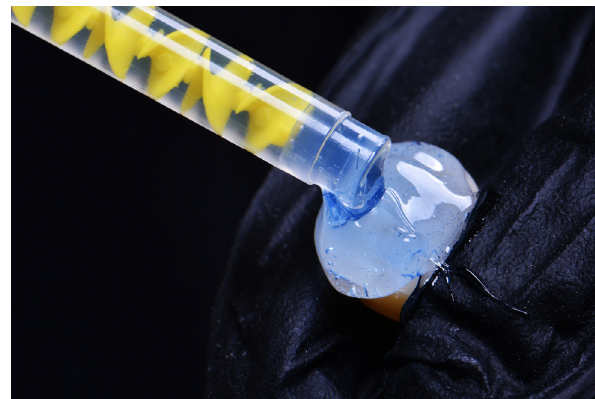
Figure 1: Occlusal stamp preparation by using a transparent silicone material, Exaclear, GC